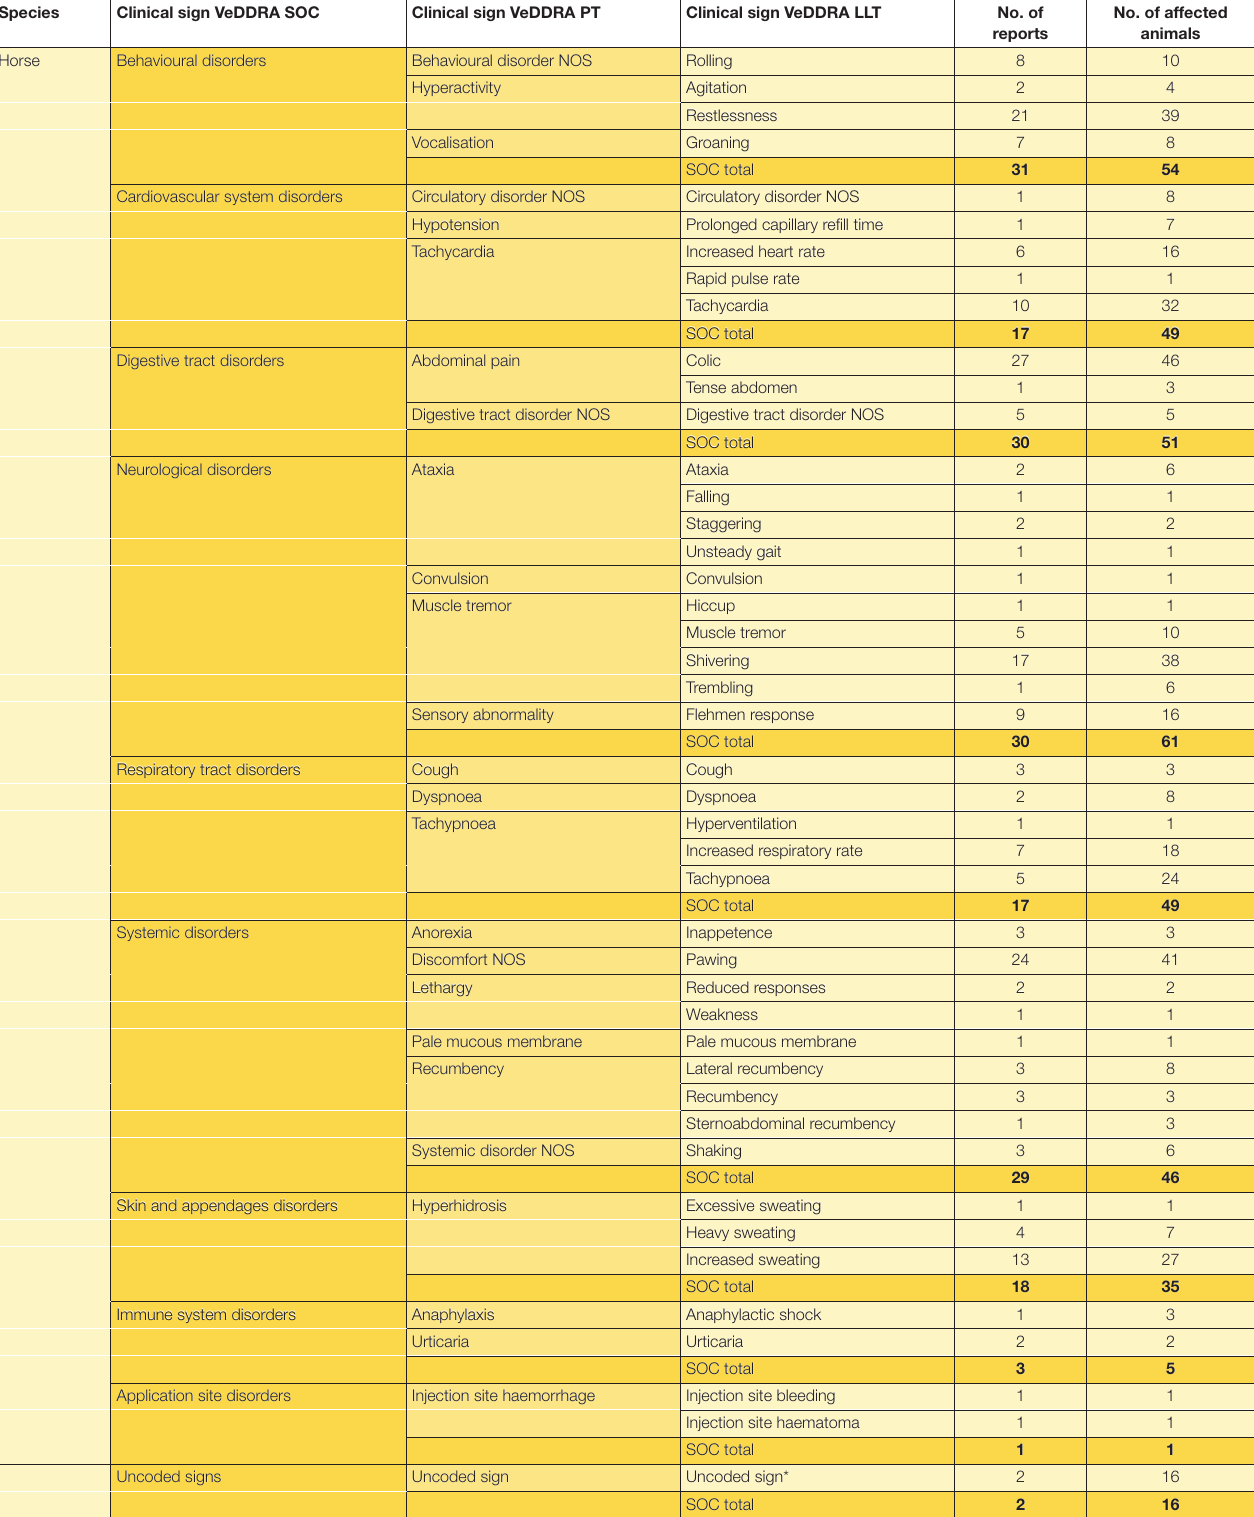
TABLE 1 | Count of clinical signs reported as adverse events coded by VeDDRA terminology (2) (SOC, system organ class; PT, preferred term; LLT, low-level term) of conspicuous batches.